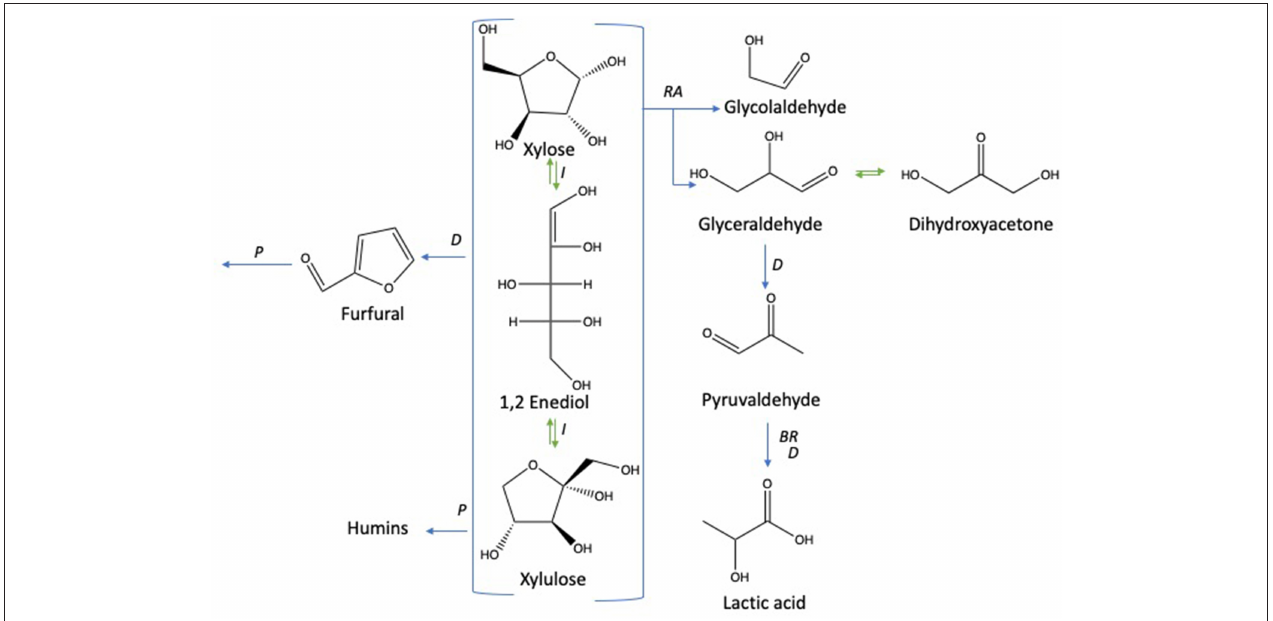
FIGURE 1 | D-xylose conversion pathways in subcritical water adapted from the works of Aida et al. (2010), You et al. (2014), and Delbecq et al. (2018). Reactions: D, dehydration; P, polymerization; BR, benzilic acid rearrangement; I, isomerization; RA, retro-aldol.